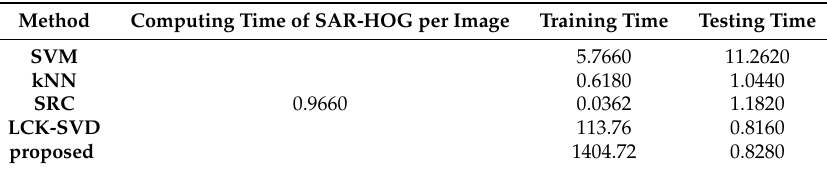
Table 21. The time consumption of different methods